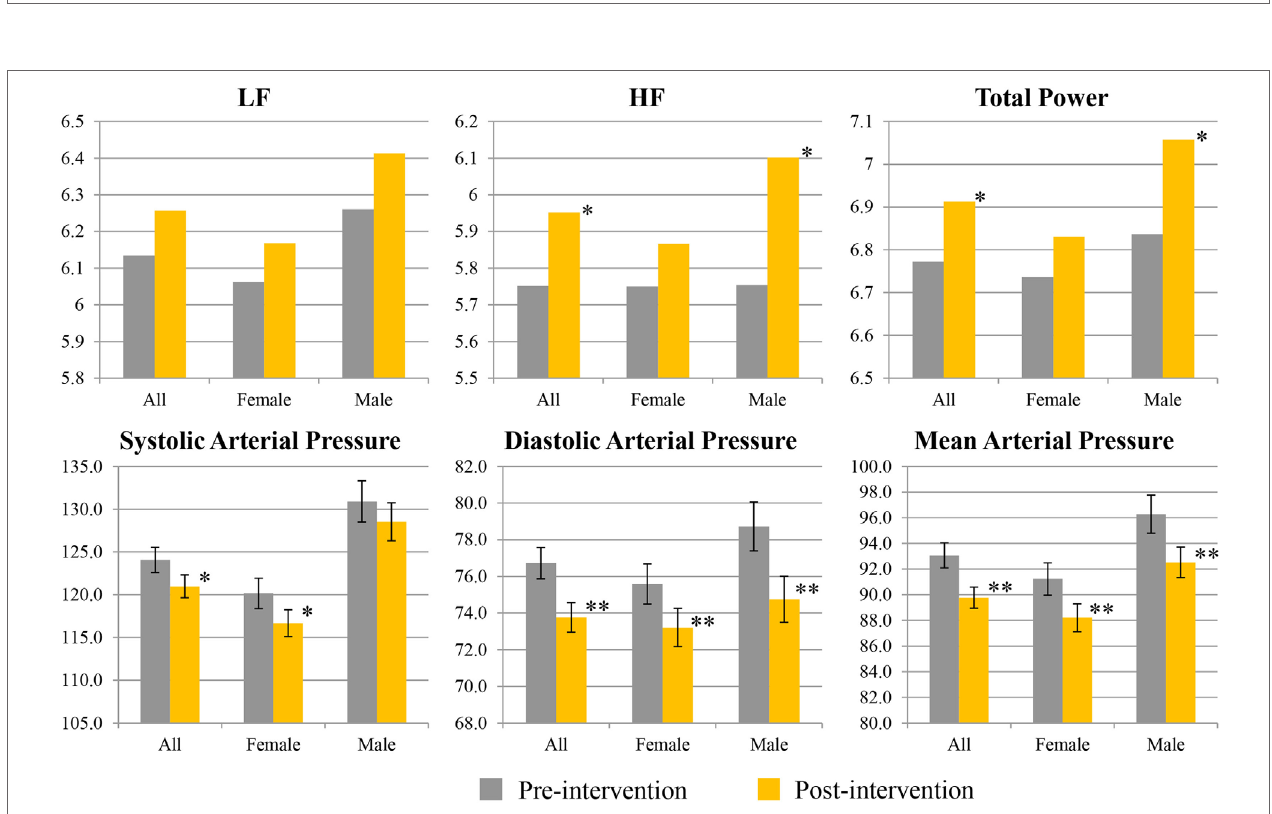
FigUre 2 | Post-interventional changes in heart rate variability and baroreflex sensitivity on percentage basis. Bars indicate ± SEs for the average percent changes. All changes were statistically significant at p < 0.001 except the following, for men: RMSSD, SBP DOWN, SBP ALL ( p < 0.01 for each), and SBP UP ( p = 0.02).